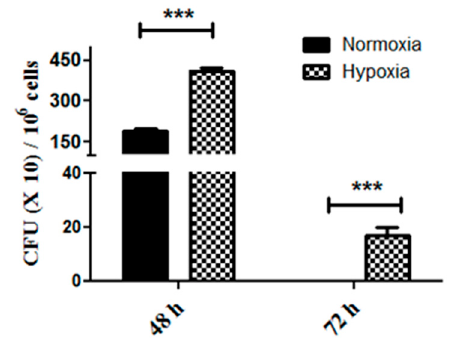
Figure 2. P. gingivalis intracellular survival assay. PANC1 cells were infected with P. gingivalis for 1 h in normoxic vs. hypoxic conditions and treated with antibiotics to remove all extracellular bacteria. Cells were lysed at the indicated time points, and lysates were plated on anaerobic blood agar plates to determine CFU. The experiment was performed three times. Data show the mean ± SD of a